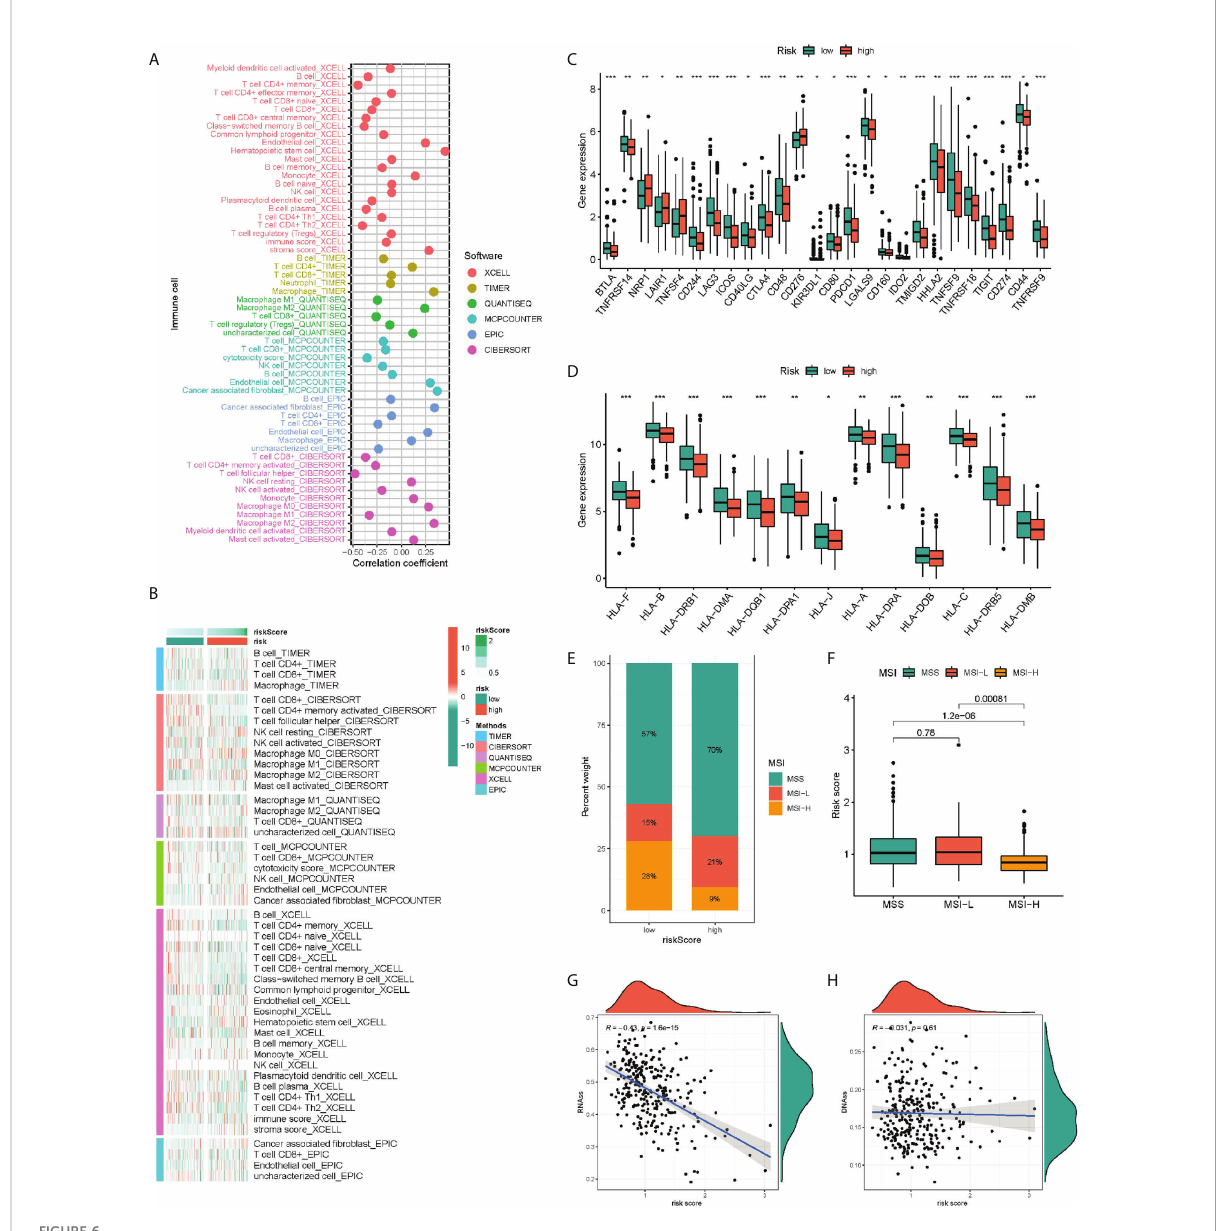
FIGURE 6 Immunity analysis of the PRR-related prognostic signature. The correlation of tumor-in fi ltrating cells with risk score using 6 algorithms. (A) Heatmap. (B) lollipop plot. (C) Expression of immune checkpoints in the high and low-risk groups. (D) Comparison of 13 HLA-related genes expression levels in two risk score subgroups. (E – H) The correlation of the risk score and MSI and TSI. *P<0.05, **P<0.01,